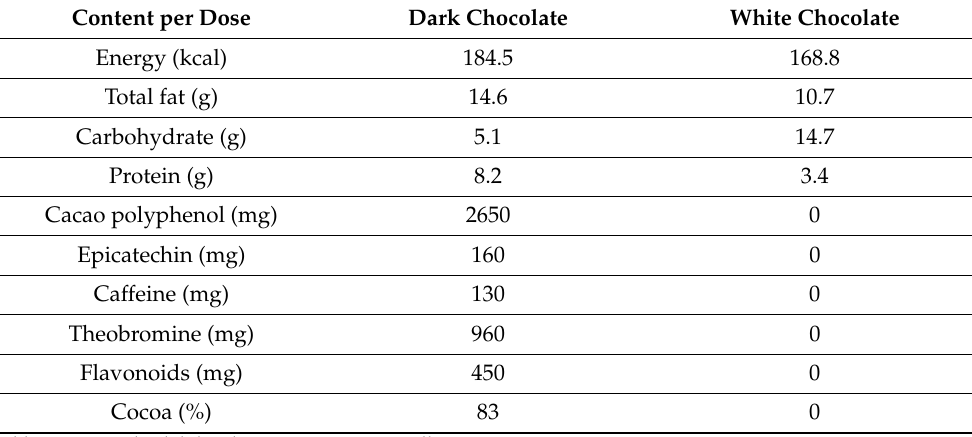
Table 2. Energy and nutrient composition of both dark and white chocolate supplements. Content per Dose Dark Chocolate Energy